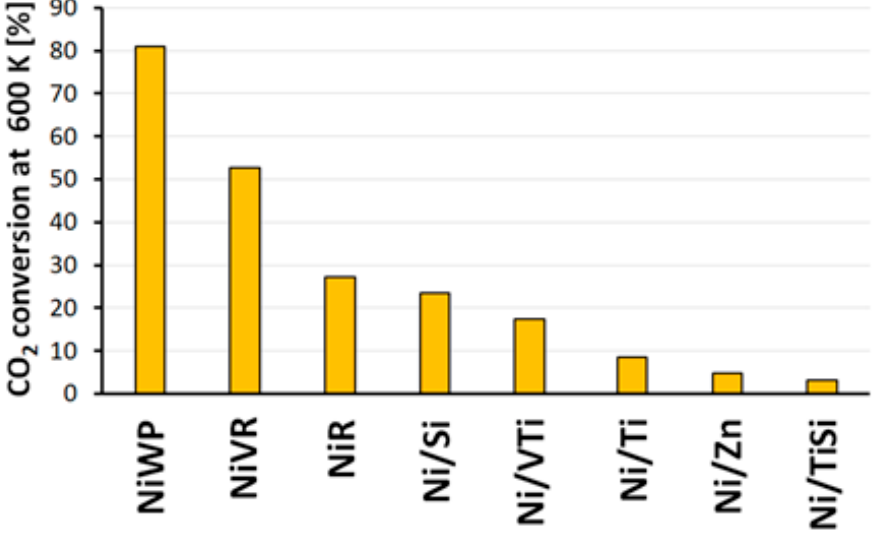
Figure 6. Catalyst activity measured as CO 2 conversion at 600 K.